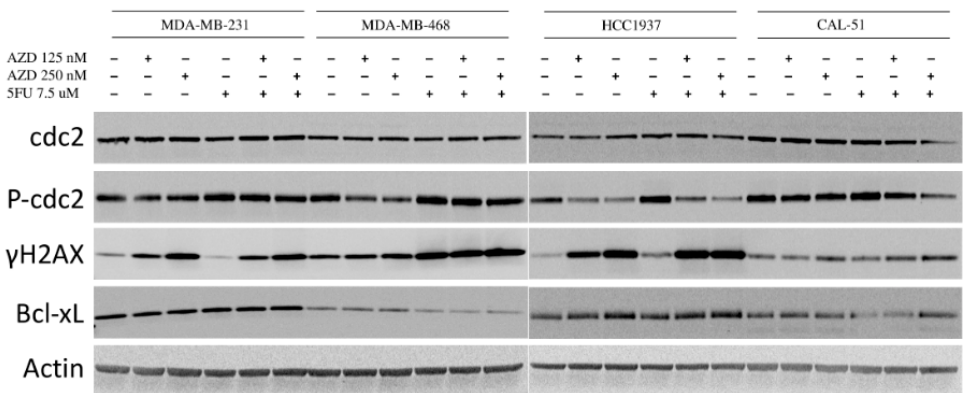
Figure 7. Effects of AZD1775 and 5FU on relevant downstream effectors of the cell cycle and DNA damage. Cells were treated with AZD1775 and 5FU for 48 h and total protein was extracted. Whole cell extracts were assessed for expression of CDC2. p-CDC2, γ H2AX, and Bcl-xL by immunoblotting.